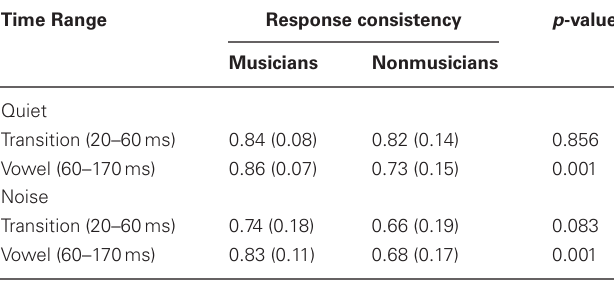
Table 5 | Response consistency scores (Pearson r -values): means (with SDs) for the musicians and nonmusicians across the transition and the